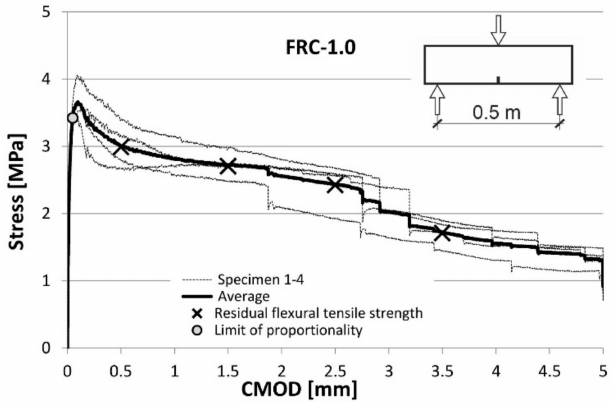
Figure 9. Stress-CMOD curves from flexural tests on FRC-1.0.